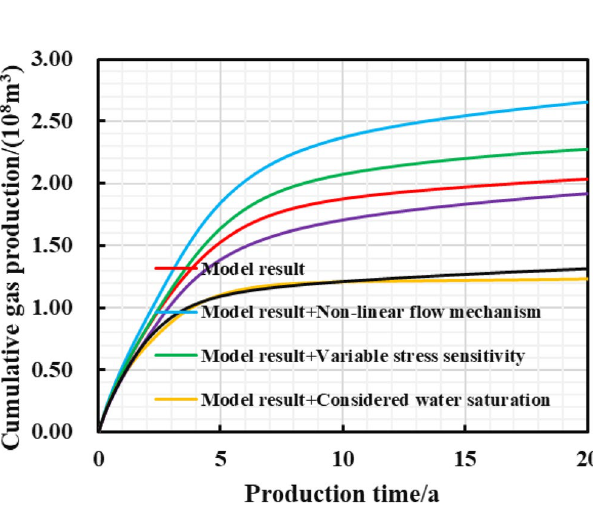
Figure 16. Diagram of the daily gas production and time for different models.